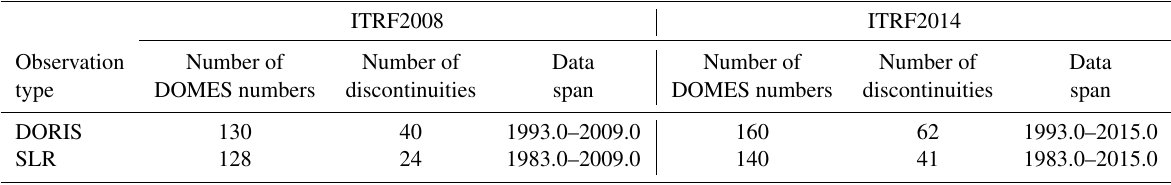
Table 1. The number of DOMES numbers and discontinuities and data span for DORIS and SLR stations in the ITRF2008 and ITRF2014.